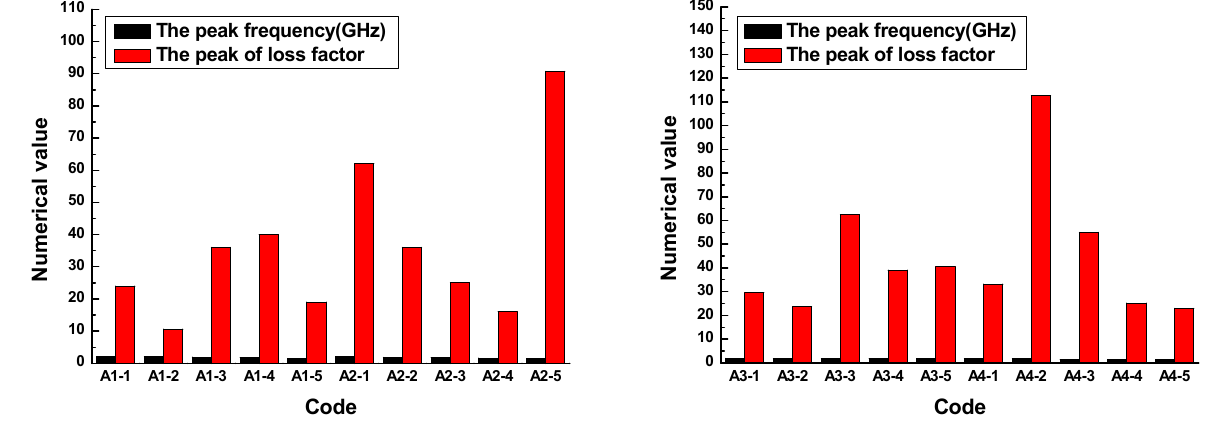
Figure 12. The peak and peak frequency of the loss factor of the rubber samples.